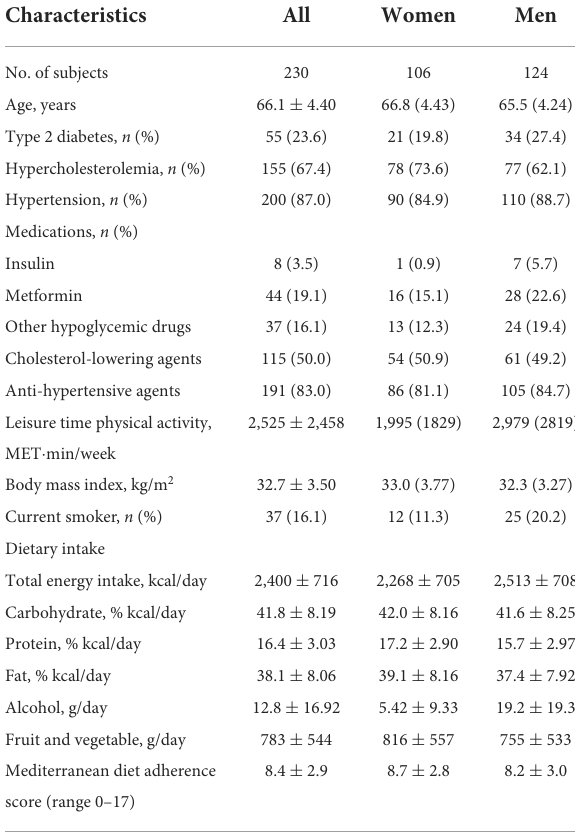
TABLE 1 General characteristics of the